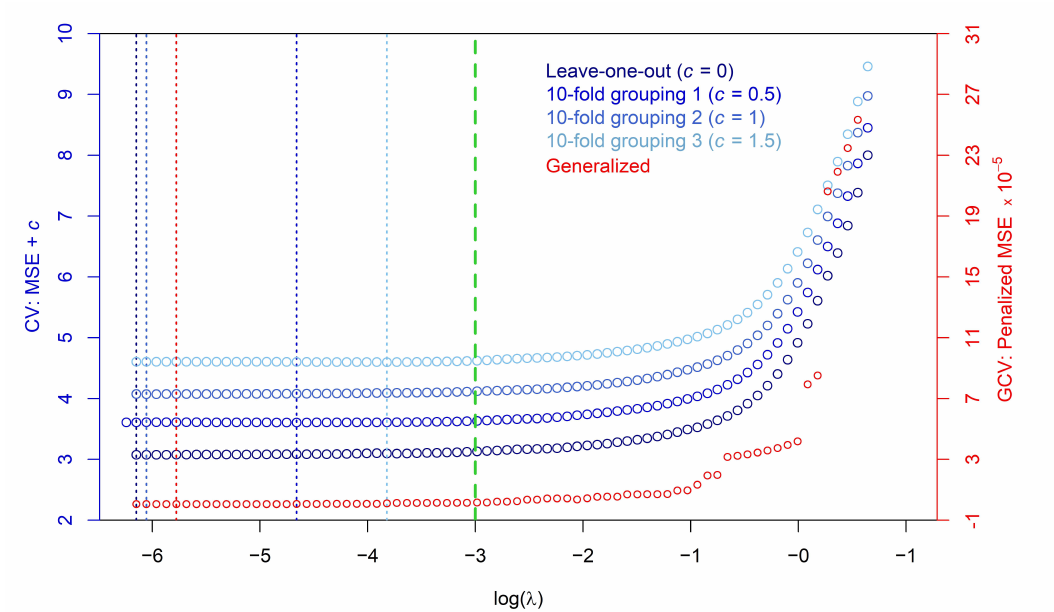
Figure 4. Cross-validation approaches for the selection of λ in the Least Absolute Shrinkage and Selection Operator (LASSO) regression. The horizontal axis represents different values of λ . The left vertical axis represents the mean squared error (MSE) objective function for the leave-one-out and 10-fold cross-validation (CV) approaches, where a constant c is added to avoid overlapping and to facilitate visualization. The right vertical axis represents the penalized MSE for the generalized cross-validation (GCV). The vertical dotted lines with colors corresponding to the curves represent the values of λ at which the corresponding objective functions reach their minimum value for each approach. The green dotted line represents the value of λ of maximum regularization (least number of potential predictors with non-zero regression coefficients) for which changes in the objective functions are negligible with respect to the optimal